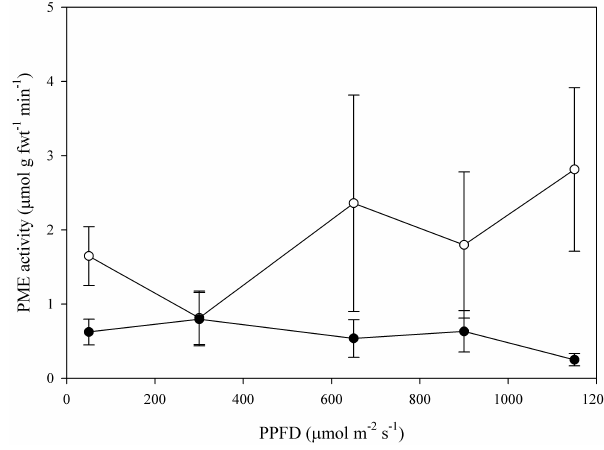
Fig. 2. Average MeOH flux values normalized for stomatal conduc- tance ( g s ) over five light levels for n = 5 mature (black circles) and immature (white circles) L. esculentum (each plant was measured 5x; standard error bars shown). PPFD had no significant effect on normalized MeOH flux for either leaf type ( F = 2 . 96; df = 1, 19; P = 0 . 10 for mature; F = 0 . 6; df = 1, 19; P = 0 . 45 for immature).